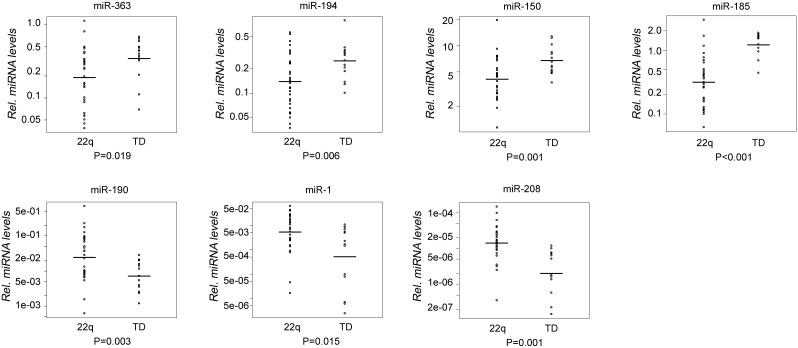
Altered miRNA expression in 22q11DS.Relative miRNA levels are shown for 7 miRNAs that demonstrated differential expression levels when comparing 30 individuals with 22q11DS and 15 TD individuals. miRNA levels were normalized to the reference U6 snRNA. Circles represent observed data. Horizontal lines represent geometric means. Respective p-values are shown.